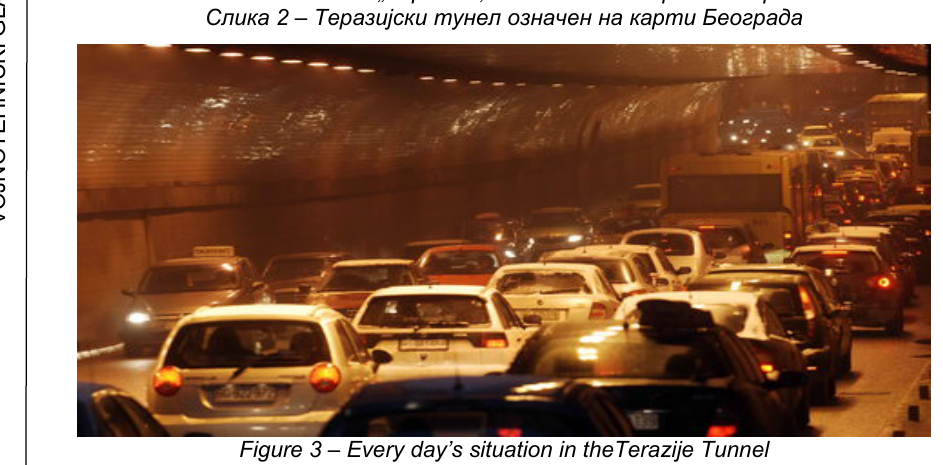
Figure 3 – Every day’s situation in theTerazije Tunnel Рис . 3 – Будни в тоннеле „ Теразие “ Слика 3 – Свакодневни призор у Теразијском